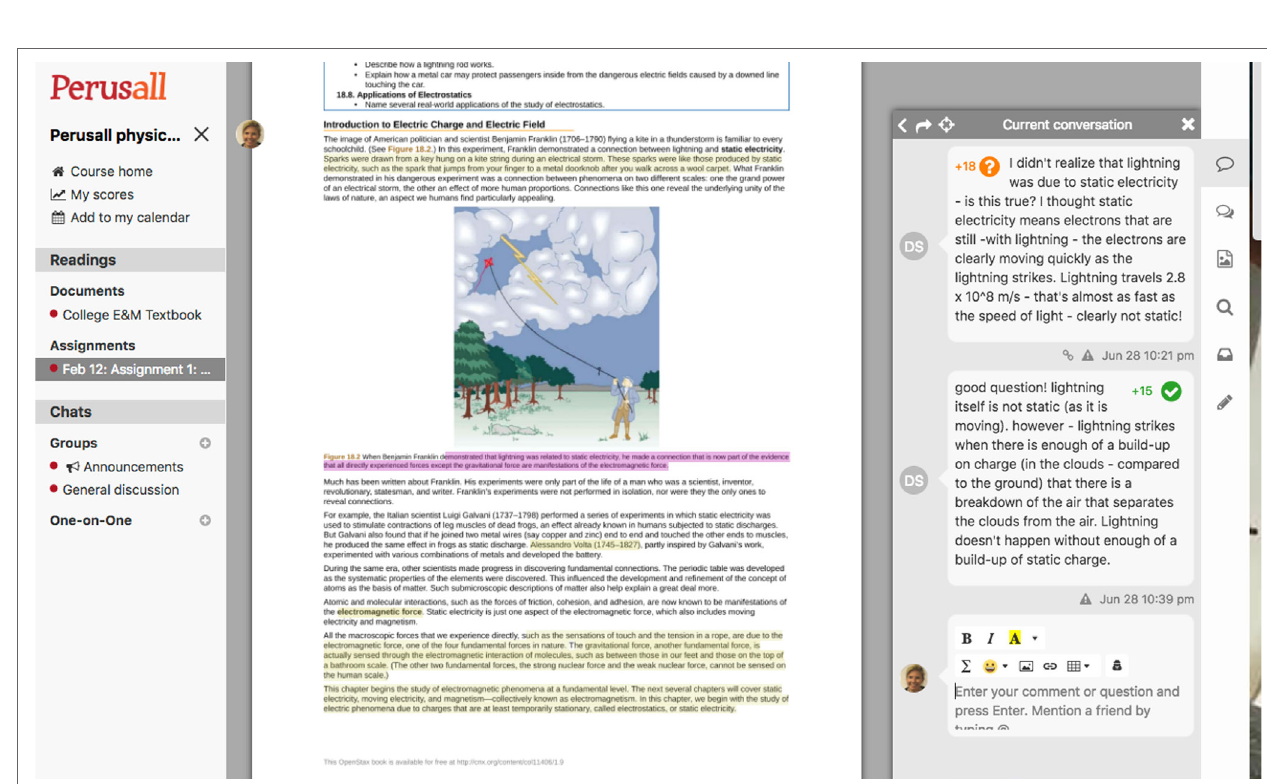
FigUre 2 | Page of a reading assignment in Perusall. (Note: the depicted individual provided written informed consent for the publication of their identifiable image, the image of the textbook book is from OpenStax, University Physics, Volume 1. “Download for free at https://openstax.org/details/books/university-physics- volume-1,” no further permission is required from the copyright holders for the reproduction of this